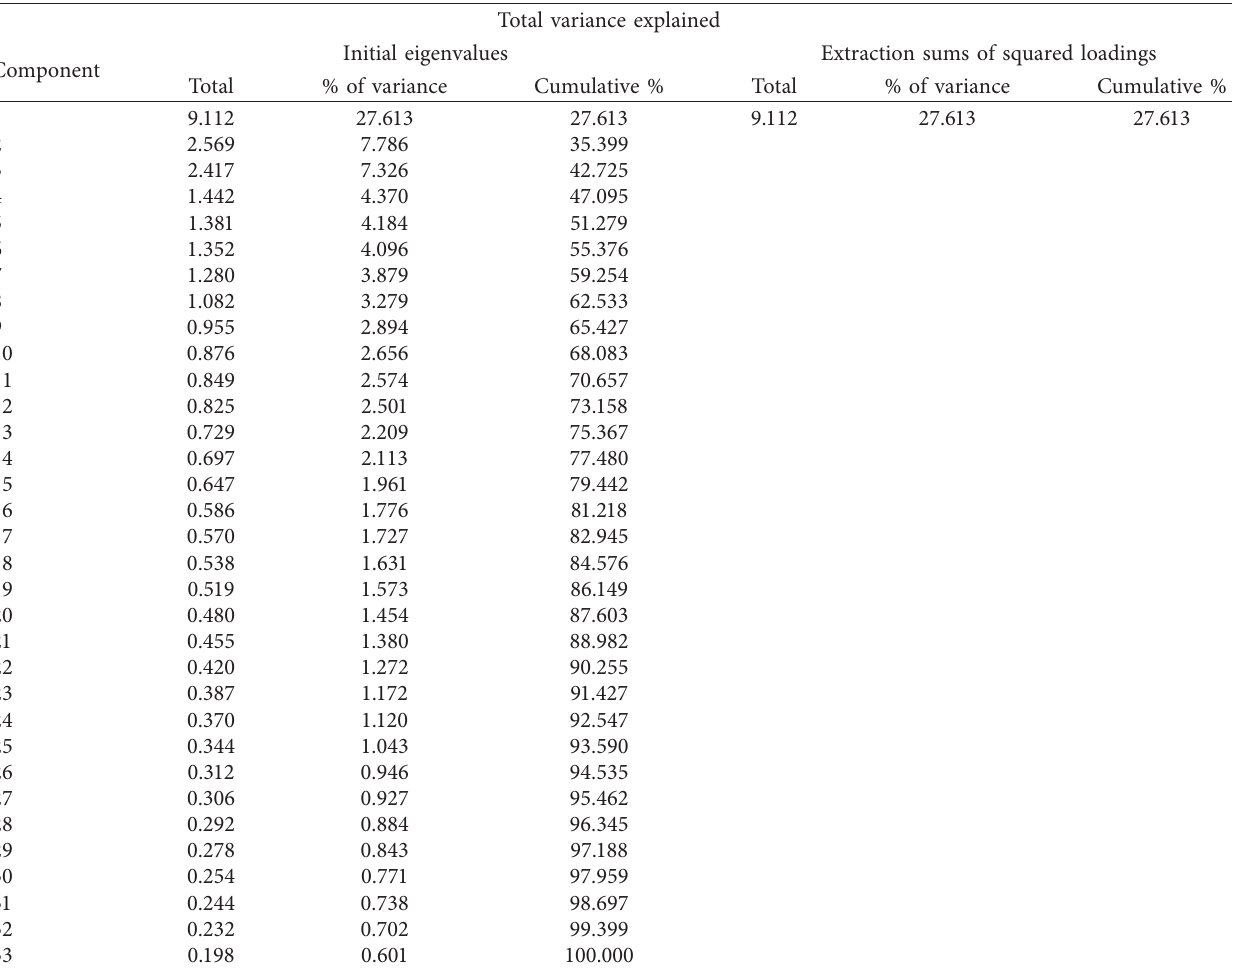
Table 7: Common method bias (CMB) through Harman’s single factor method.